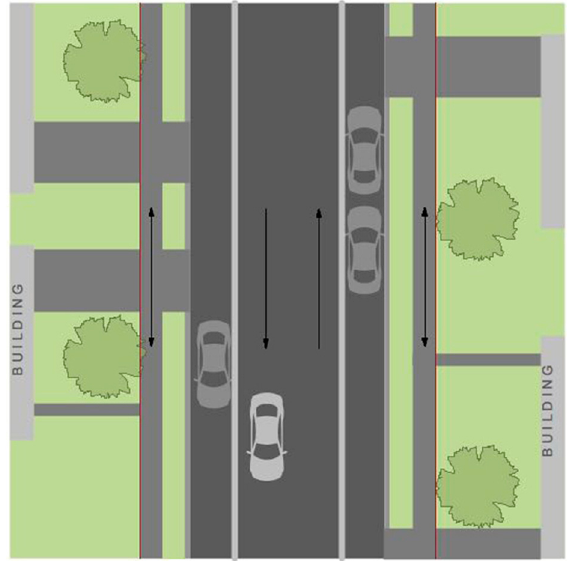
Figure 1. Example of a typical suburban street design (plan view; not to scale).